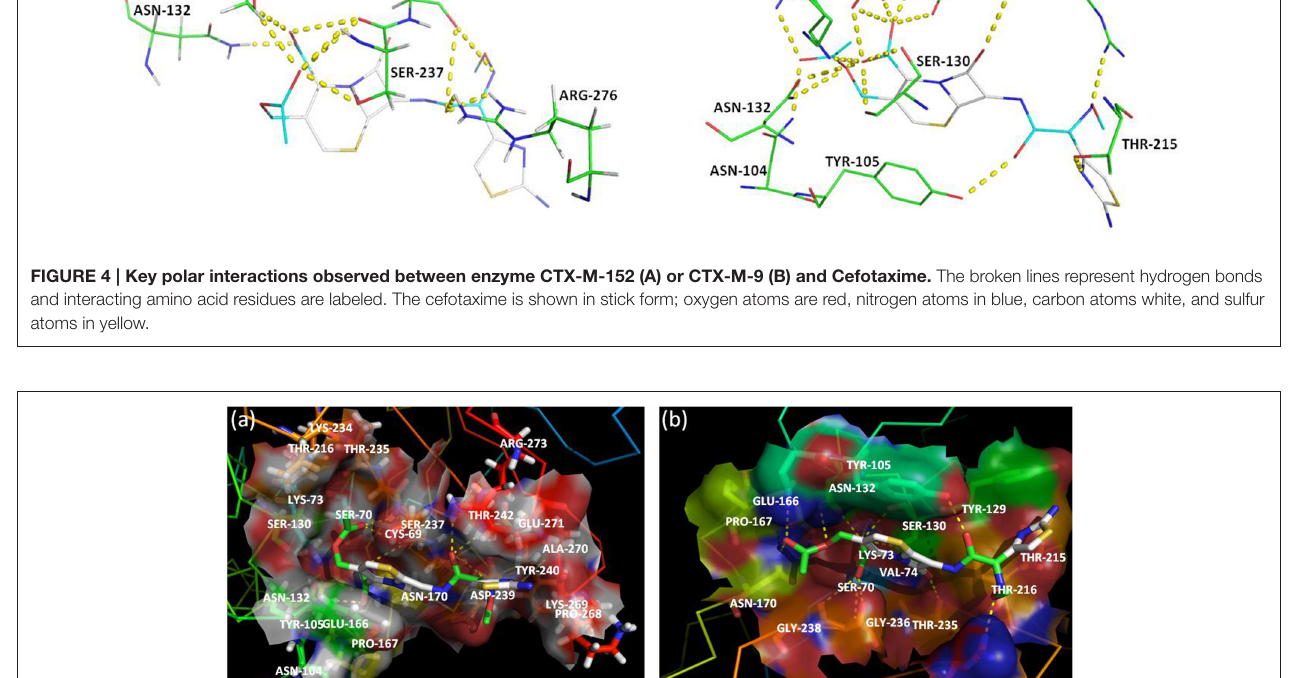
FIGURE 5 | Active site of CTX-M-152 (A) and CTX-M-9 (B) with substrate cefotaxime. Residues around the binding pocket of substrate are depicted in transparent cloud form. The cefotaxime is presented in stick form; oxygen atoms are red, nitrogen atoms in blue, carbon atoms white, and sulfur atoms in yellow.